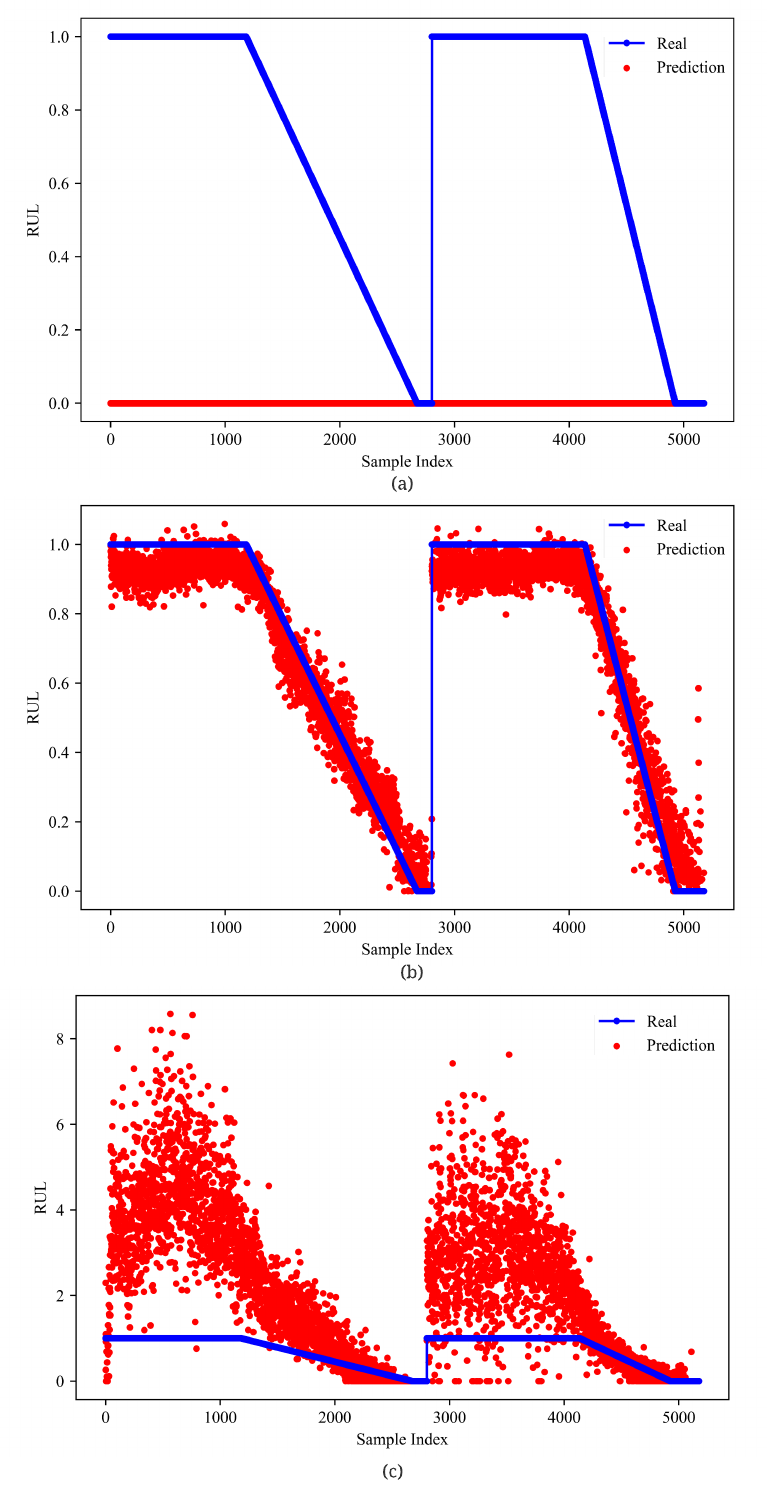
Figure 12. RUL prediction of models ( a ) 0 Gate. ( b ) 1 Gate(GMM-Net); ( c ) 2 Gates. Samples from bearing 1_1 and bearing 1_3 are joint from left to